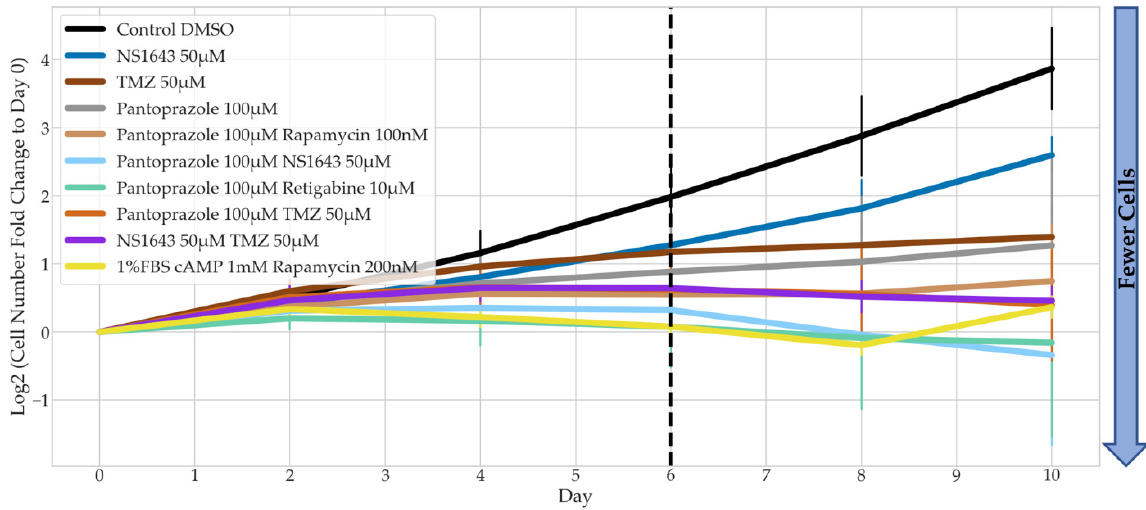
Figure 6. Recovery Test of Bioelectric Treatments in Combination with Pantoprazole or TMZ in U87 cells. The log2 of the fold change in cell counts to Day 0 were recorded for 10 days. Dotted line marks the day on which drug treatment was removed and replaced with control media ( n > 3 biological replicates). Combination drug treatment slopes from Day 6 to Day 10 were compared to pantoprazole or TMZ alone, but no significance was found (one-way ANOVA with Dunnett post hoc analysis n > 3 biological replicates). 3.5. Electrophysiology of NG108-15 Cells Show Changes in Resting